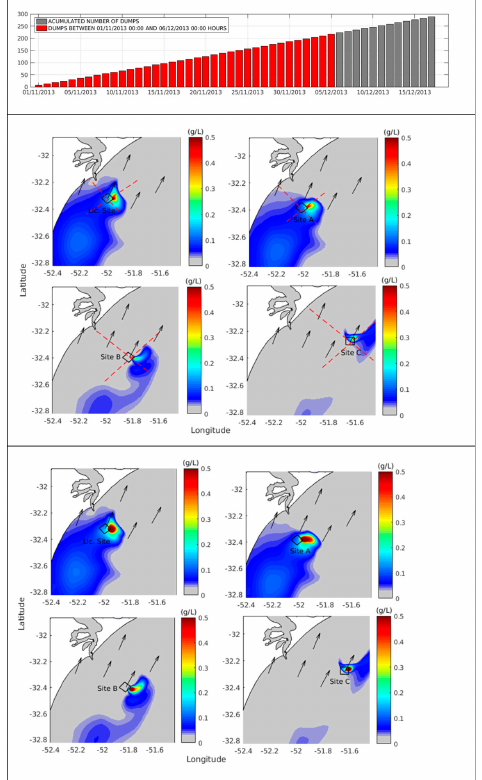
Figure 7. Top panel—Accumulated number of discharges on 06 December 2013 at 00:00 h. Dispersion plume at the surface (central panel) and at the bottom (bottom panel) after 216 discharges on the Licensed and alternative disposal Sites A, B, and C. Color scale indicates suspended sediment concentrations (g/L), where gray indicates concentrations lower than 0.025 g/L and red indicates concentrations varying from 0.5–8 g/L. Red dotted line indicates the position of the longitudinal and transversal profiles for which results were extracted. Black arrows indicate the wind direction from the SW. Wind velocity during this event was 9.8